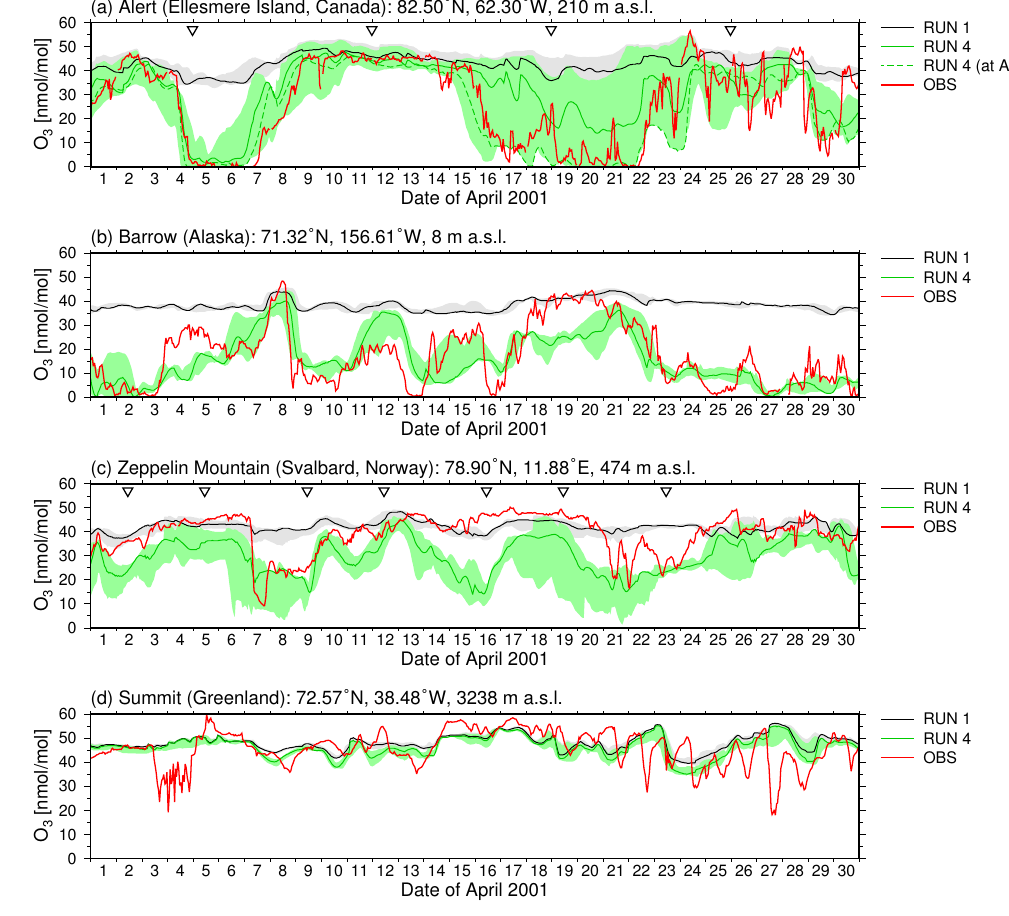
Fig. 3. (a) Comparison of surface ozone mixing ratios simulated in Run 1 (black line) and Run 4 (green lines) with observations at Alert GAW station during April 2001. The solid lines represent simulated time series at the nearest grid cell at the lowest model level, while the range of the simulated values across the nearest and surrounding eight grid cells is indicated by gray and light green shadings (for Run 1 and Run 4, respectively). The red lines, disconnected where missing data points exist, represent hourly observational data. For the simulated time series from Run 4, we also include the values at a neighboring grid cell to the north of Alert (location A 0 in Fig. 2b) at the third lowest vertical level of the model ( ∼ 170ma.s.l.) represented by the green dashed line; (b) the same as (a) but at Barrow; (c) the same as (b) but at Zeppelin, where the simulated values at the nearest and surrounding grid cells are taken from the model vertical levels closest to the station level (474ma.s.l.); and (d) the same as (b) but at Summit. Inverted triangles in (a) and (c) indicate the launching time of ozonesonde at Alert CFS near the Alert GAW station and at Ny ˚Alesund near Zeppelin, respectively (see Fig.